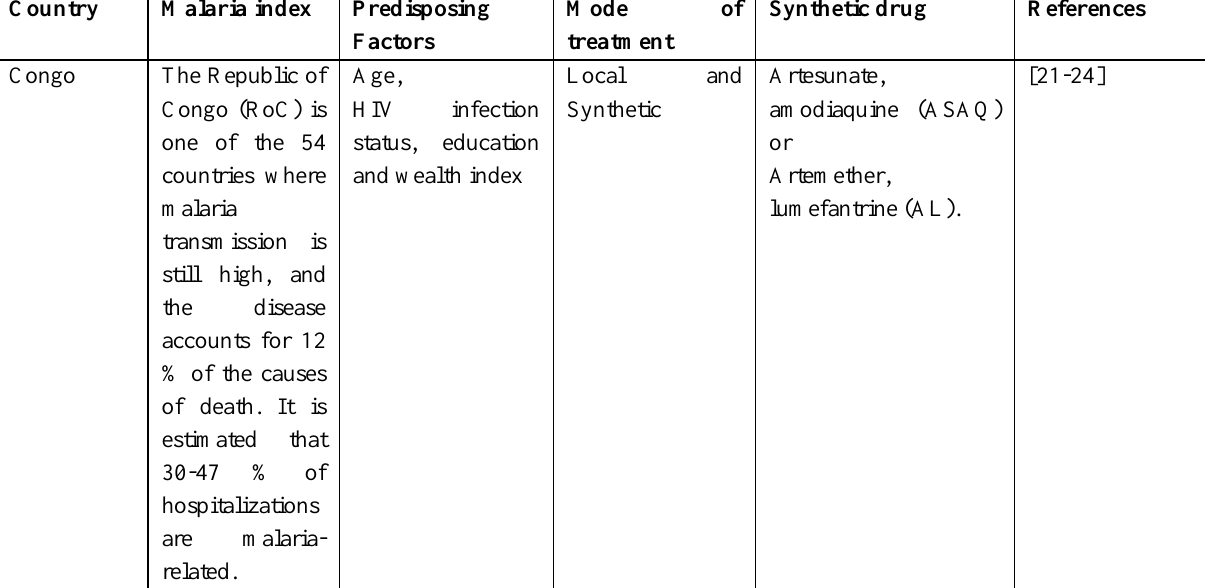
Table 1. Table showing management of malaria in different parts of Africa.